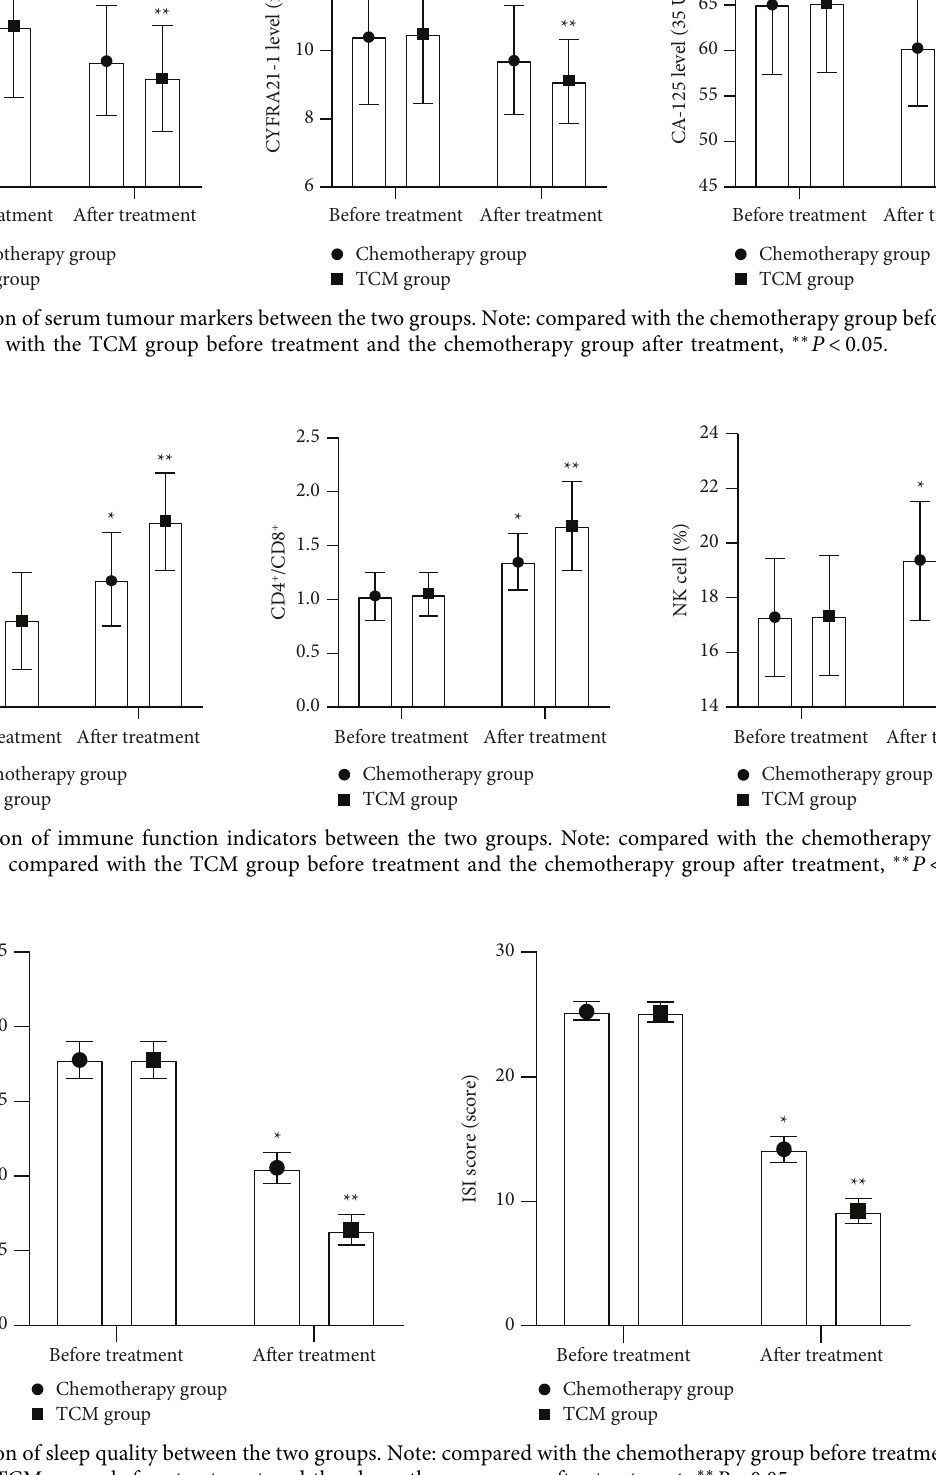
Before Figure 3: Comparison of sleep quality between the two groups. Note: compared with the chemotherapy group before treatment, ∗ P < 0 . 05; compared with the TCM group before treatment and the chemotherapy group after treatment, ∗∗ P < 0 .